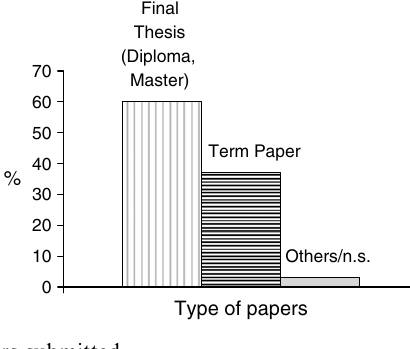
Figure 3. Type of papers submitted.